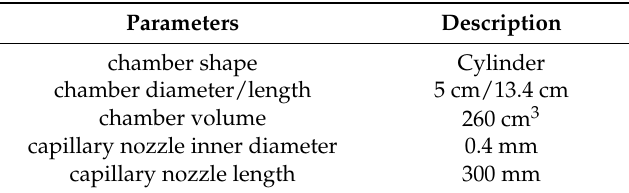
Table 2. Dimensions of high-pressure flashing-spray